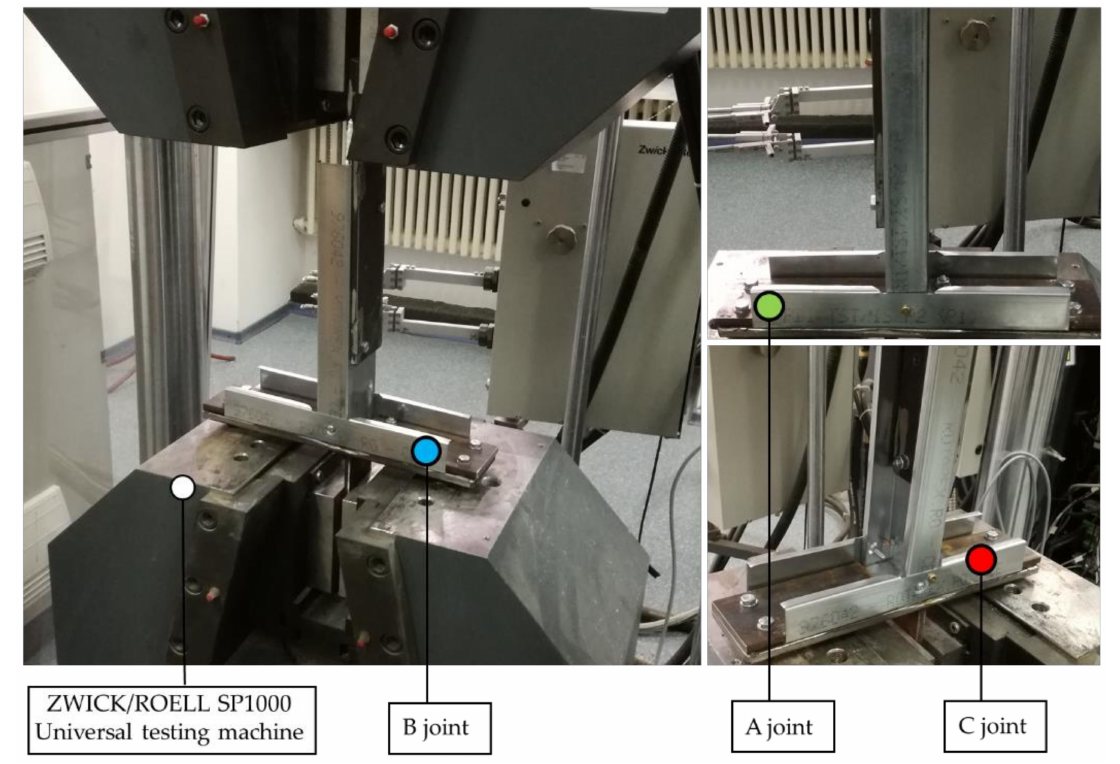
Figure 12. Universal Testing Machine Zwick/Roell SP 1000 and the tested joints A, B,